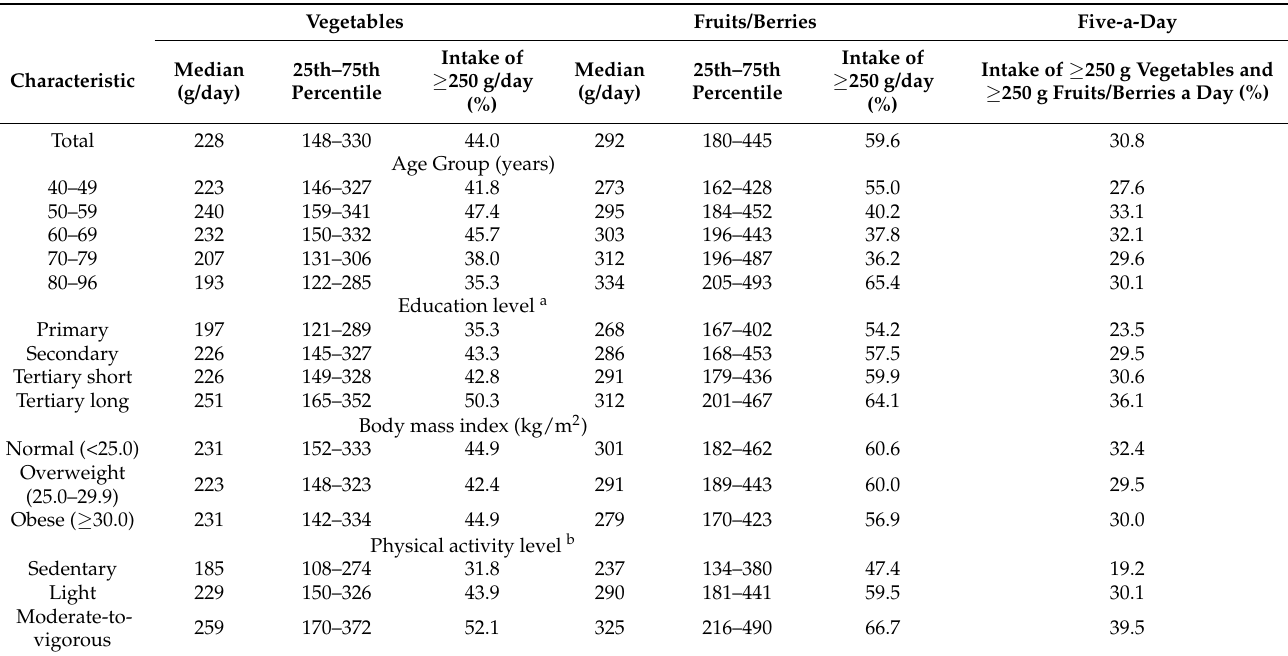
Table 2. Median intake of vegetables, fruits and berries in women, and proportion compliant with recommendations.